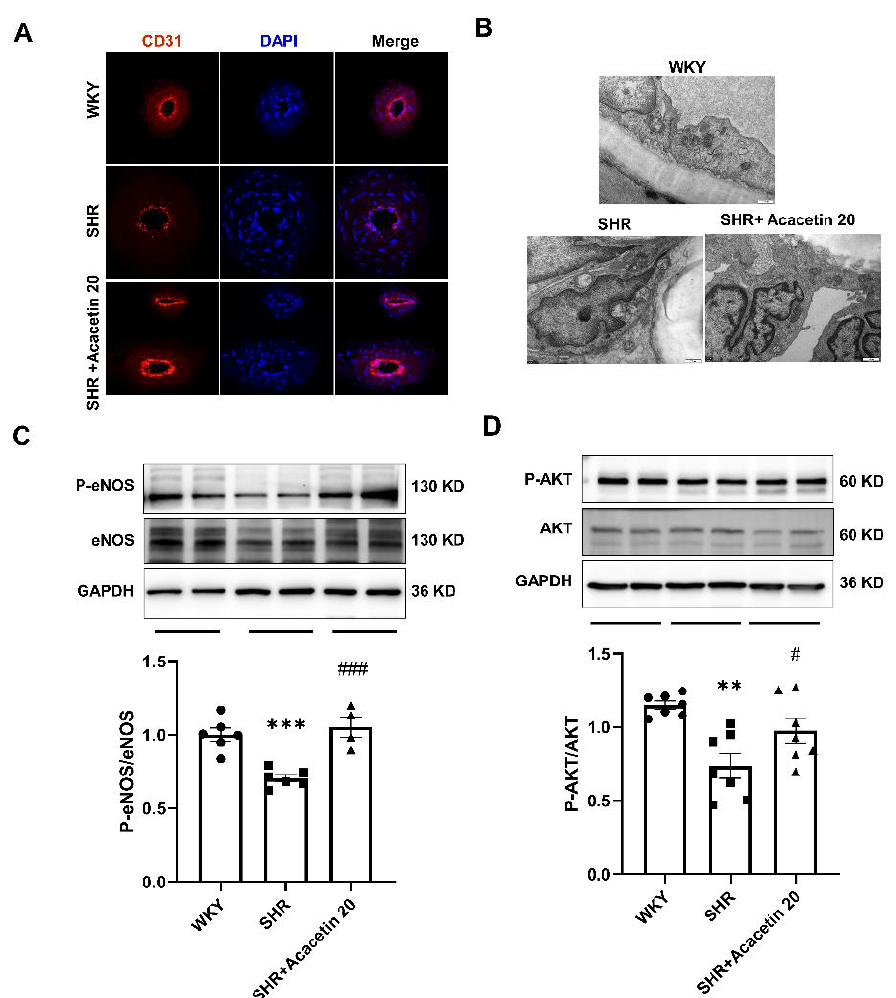
Figure 4. Acacetin reversed endothelial injury in SHR via activating the AKT/eNOS pathway. ( A ) Representative immunofluorescence staining of endothelial injury with specific endothelium marker CD31 (400 × ). ( B ) Representative transmission electron microscopic images showed the mitochondrial alterations in endothelial cells of mesenteric arteries in different groups (scale bar = 500 nm). ( C , D ) Repre- sentative western blot bands and quantitative analysis of p-AKT/AKT and p-eNOS/eNOS expres- sions in mesenteric arteries from WKY, SHR and SHR+Acacetin 20 group (** p < 0.01, *** p < 0.001 vs. WKY group, # p < 0.05, ### p < 0.001 vs. SHR group, n =